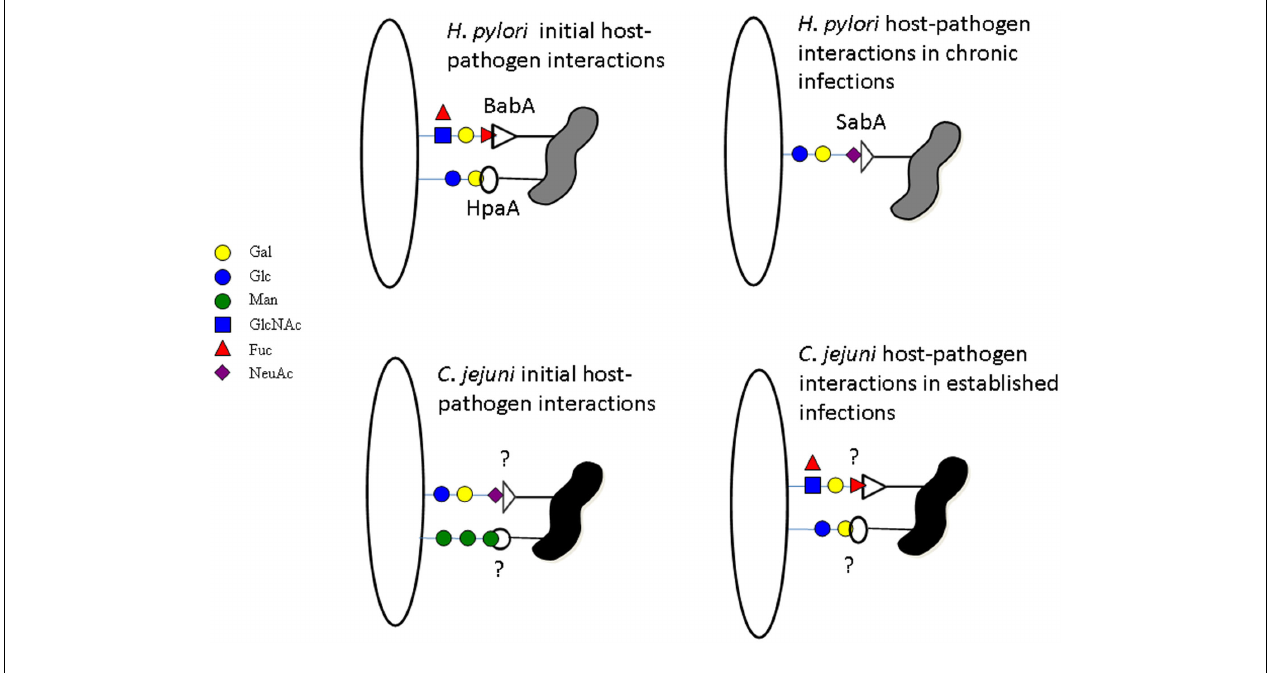
mannose for initial contact and swapping to fucose and galactose after establishing the infection.The proteins involved in H. pylori glycoconjugate recognition are known but in C. jejuni they have yet to be